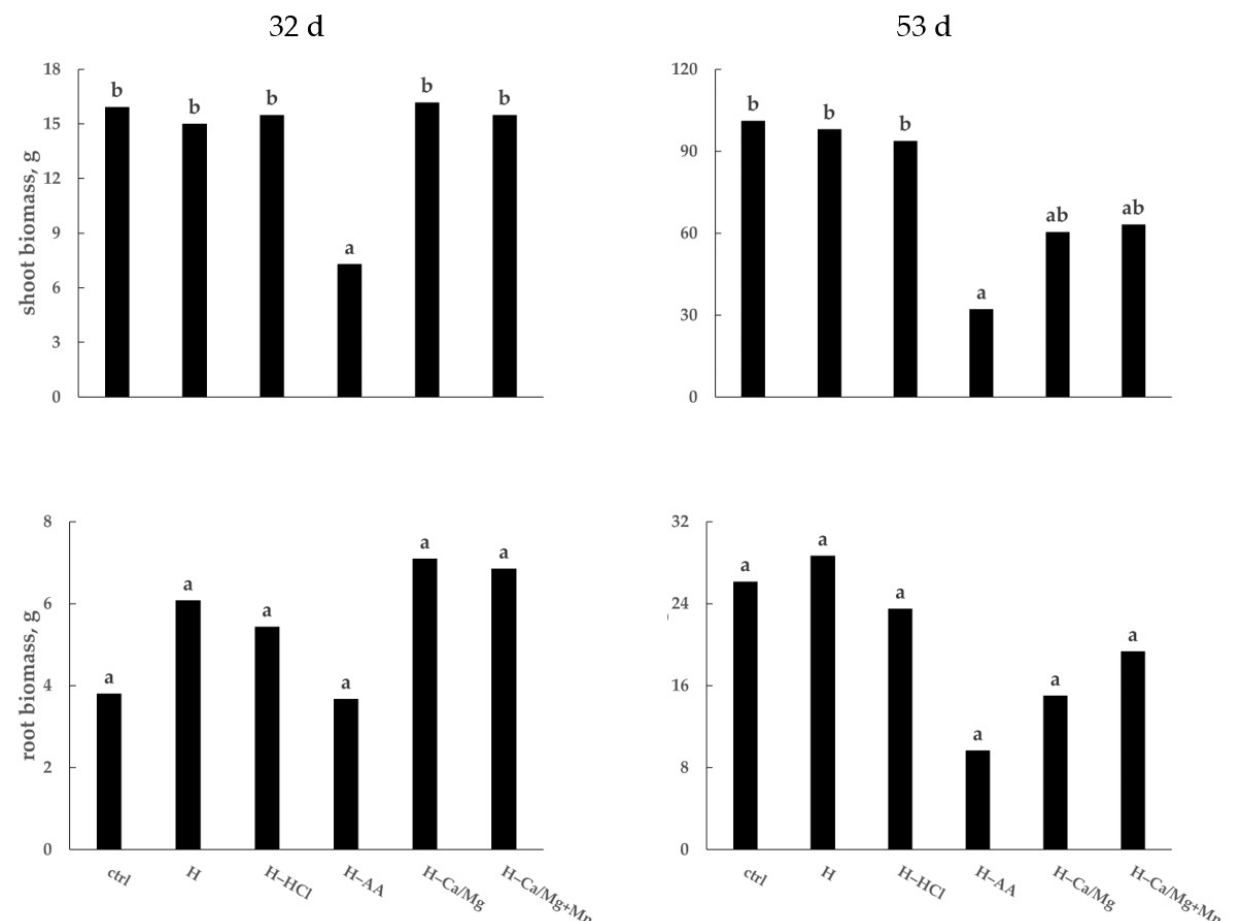
(Table 3). Treatment 7 (Table 1), with acetate as the Ca source, failed completely as the plants were massively stunted and sickly by 20 d.